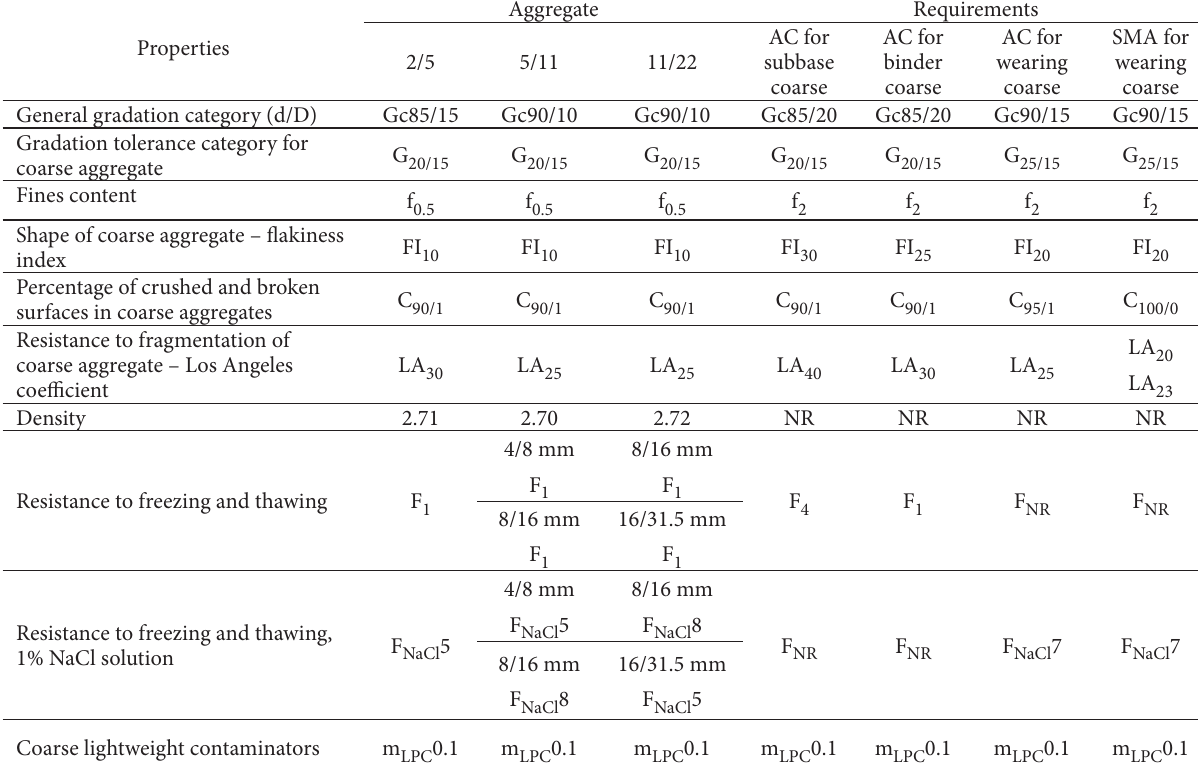
Table 2. Test results and requirements for the aggregate from the glacier formation used in the study